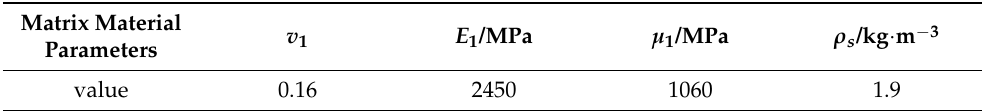
Table 2. Values of the relevant parameters of matrix materials.